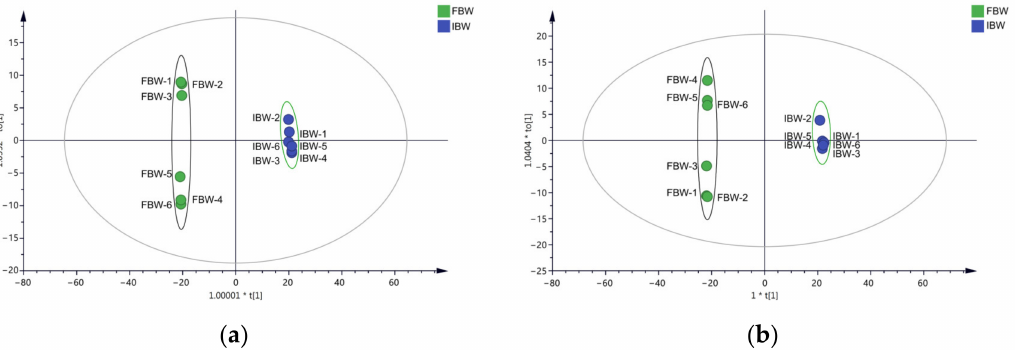
Figure 4. The OPLS-DA score plots of soluble compounds detected by electrospray ionization (ESI), with positive and negative ion modes. ( a ) Detected by positive ion mode; ( b ) detected by negative ion